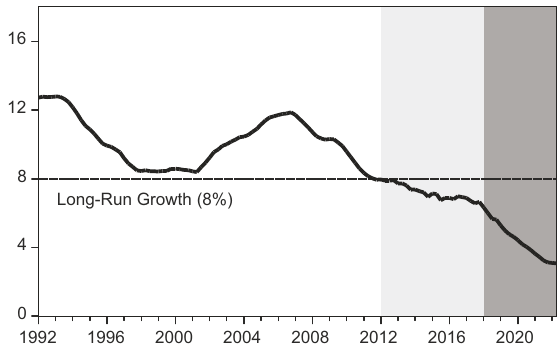
Figure 4. Posterior estimation of the trend measured by quarter-on-quarter annualized rate